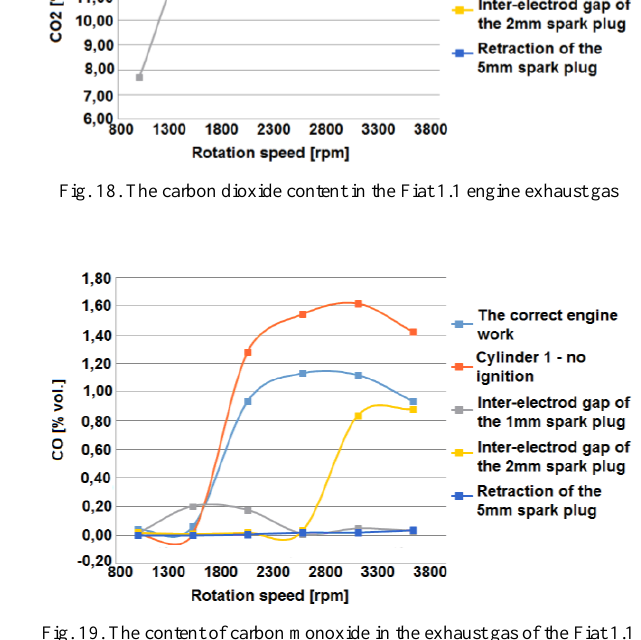
Fig 15. The value of the BMW M10B18 engine's excess air coefficient